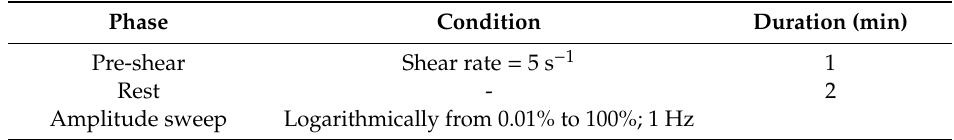
Table 2. Measurement parameters of the rheological